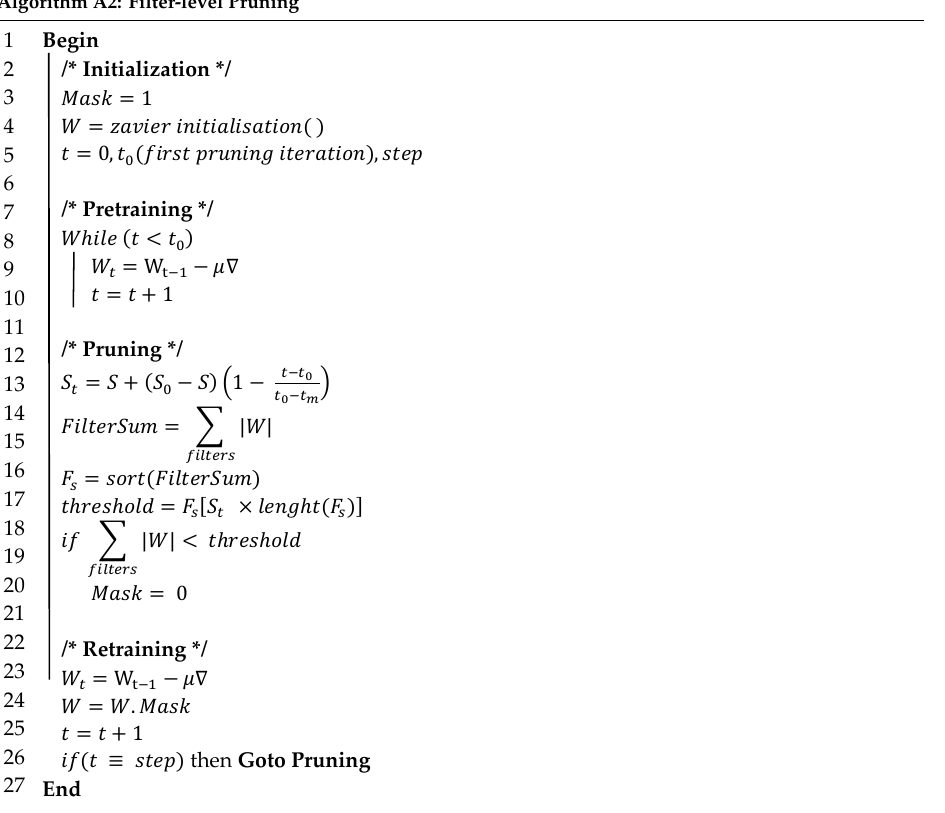
Algorithm A2 : Filter ‐ level